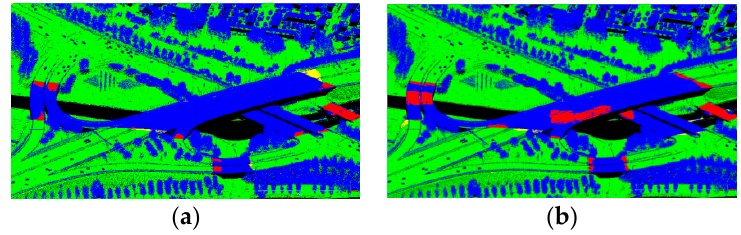
Figure 14. Result on a mixed structure of road and bridge: ( a ) FCN; ( b ) LAStools. Red points are those incorrectly labeled as ground points. Yellow points are those incorecctly labeled as non-ground points.